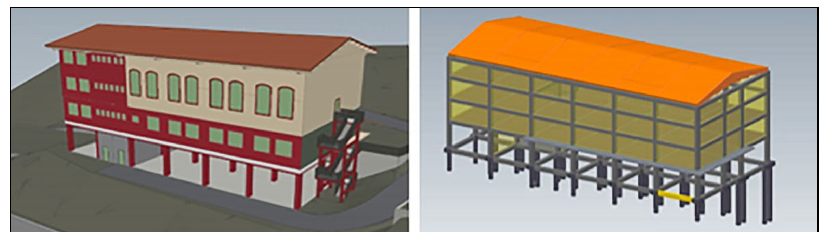
Figure 8. BIM architectural and structural models of the new school in Montemarano